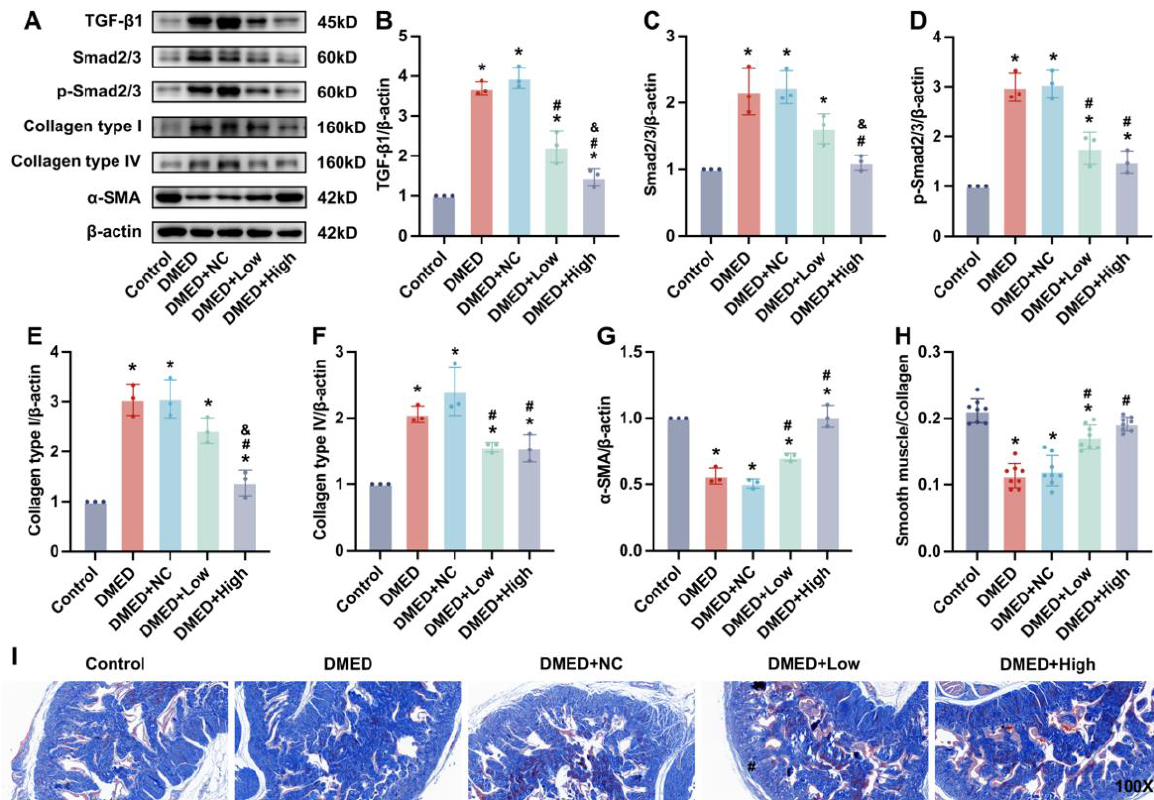
Figure 6. Effect of GPX4-LV injection on fibrosis in DMED rats. Representative immunoblot ( A ) and semi-quantification ( B – G ) of TGF- β1, Smad2/3, p - Smad2/3, Collagen type I and IV, and α -SMA in corpus cavernosum. Semi-quantification ( H ) and representative images of Masson’s trichrome staining (100×) ( I ). * p < 0.05 compared with the control group. # p < 0.05 compared with the DMED group. & p < 0.05 compared with the DMED + low group.